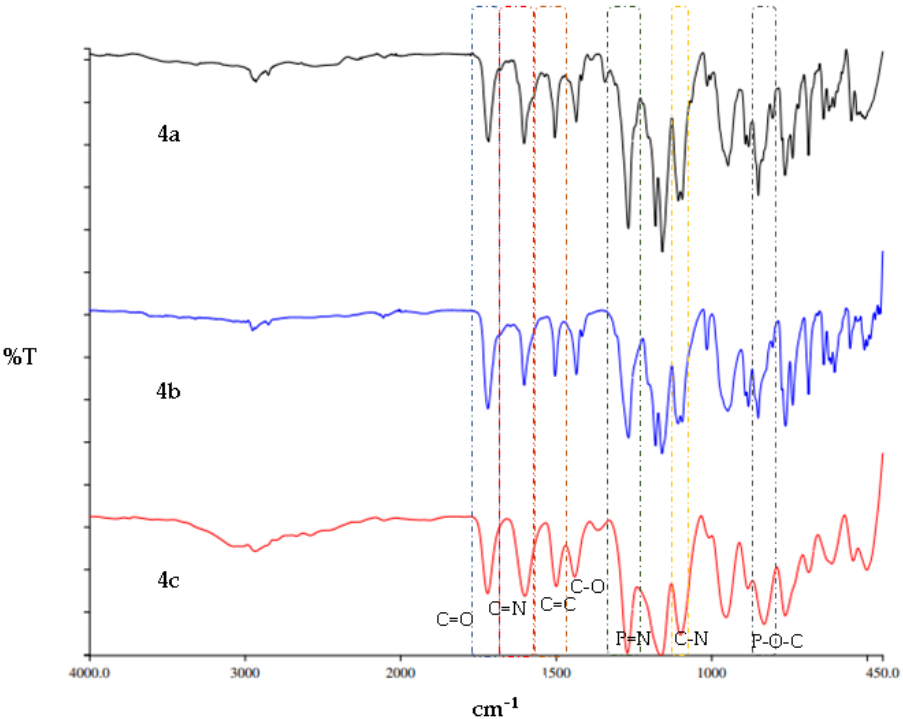
Figure 1. The overlay FTIR spectra of compounds 4a–c.